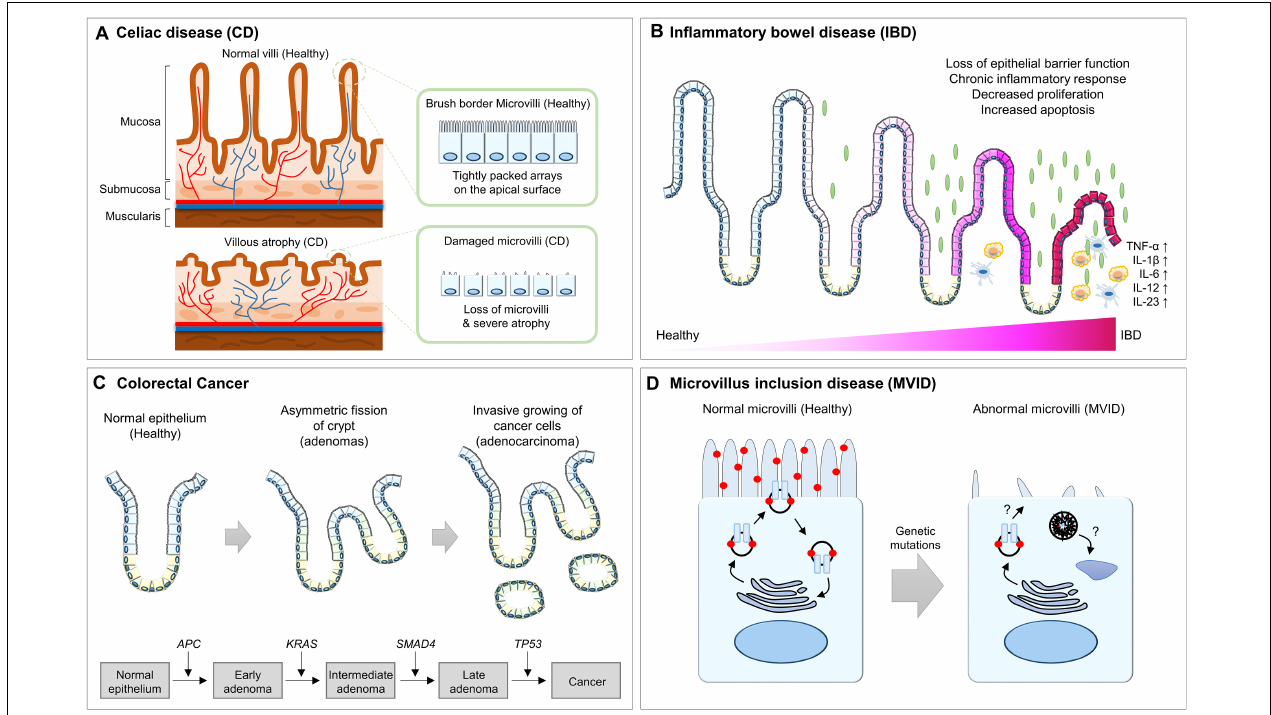
FIGURE 4 | Summary of the abnormalities of intestinal epithelium in human diseases. (A) The healthy intestinal epithelium is compartmentalized into crypt-villus structures and consists of a tightly packed array of microvilli. In CD patients, villus atrophy causes the surface area reduction of the intestinal epithelium. (B) In IBD patients, chronic inflammation results in architectural abnormalities of the intestinal epithelium, which leads to distinct morphological changes within the intestinal epithelium. (C) In CRC patients, hyperplasia of poorly differentiated intestinal epithelial cells and invasion into the submucosal layer for metastasis is frequently observed. (D) In MVID patients, microvilli are distorted or absent and are instead accumulated with microvillus inclusions, which are formed by a yet unresolved mechanism. CD, celiac disease; IBD, inflammatory bowel disease; CRC, colorectal cancer; APC, adenomatous polyposis coli; MVID, microvillus inclusion